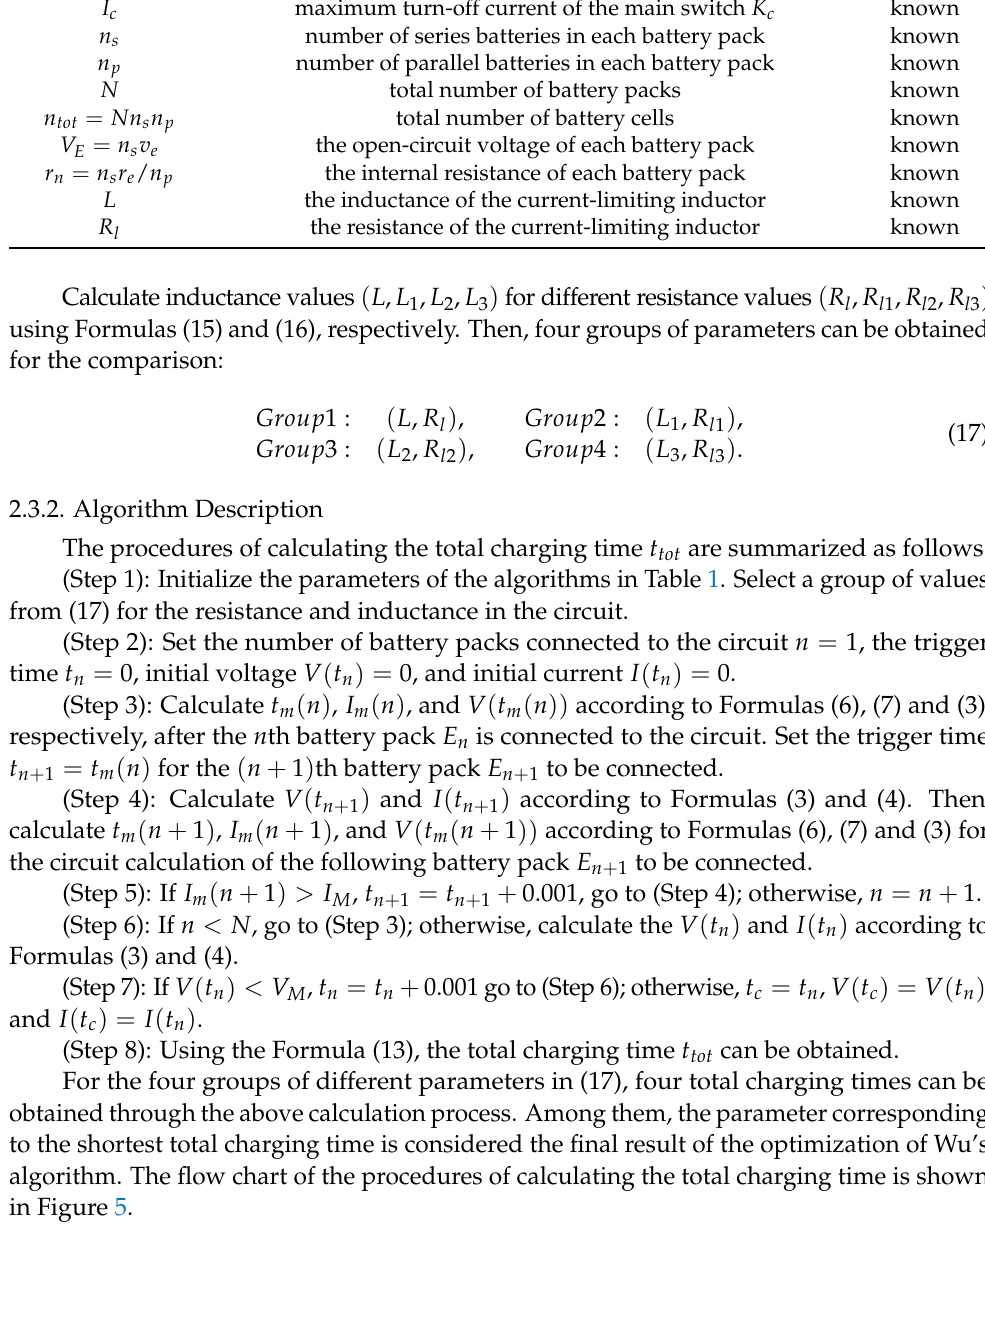
Table 1. The states of electrical parameters in the hybrid energy storage circuit before the optimization of Wu’s algorithm. Parameter Description State C the capacitance of pulse capacitor known V M required charging voltage known v e the open-circuit voltage of each battery cell known r e the internal resistance of each battery cell known I e the maximum continuous discharge current of each battery cell known I M required maximum charging current known I c maximum turn-off current of the main switch K c known n s number of series batteries in each battery pack known n p number of parallel batteries in each battery pack known N total number of battery packs known total number of battery cells known V E = n s v e the open-circuit voltage of each battery pack known r n = n s r e / n p the internal resistance of each battery pack known L the inductance of the current-limiting inductor known R l the resistance of the current-limiting inductor